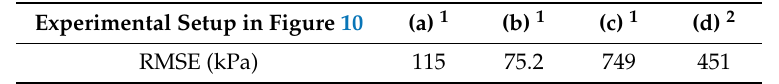
Table 1. The Root Mean Squared Error (RMSE) for multiple experimental setups to test the signal given by Equation